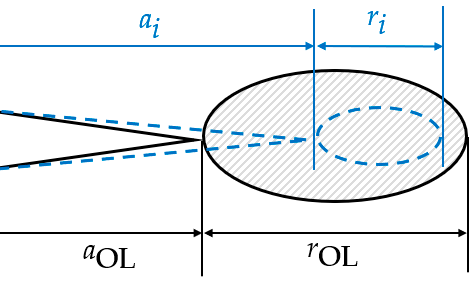
Figure 1. The plastic zone ahead of the crack